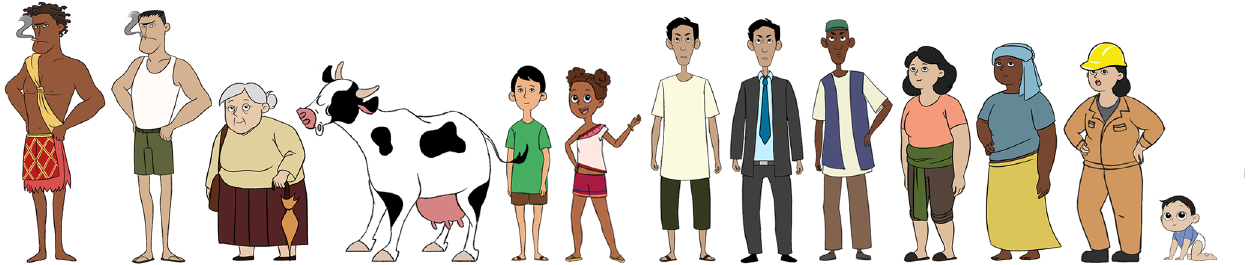
Figure 7. Line-up of sample characters for different versions of the game (left to right): street guy (Vanuatu and original), grandmother, cow, good boy, teenage girl (Vanuatu), father (rural, city, Africa), auntie (rural, Africa, factory), and baby.